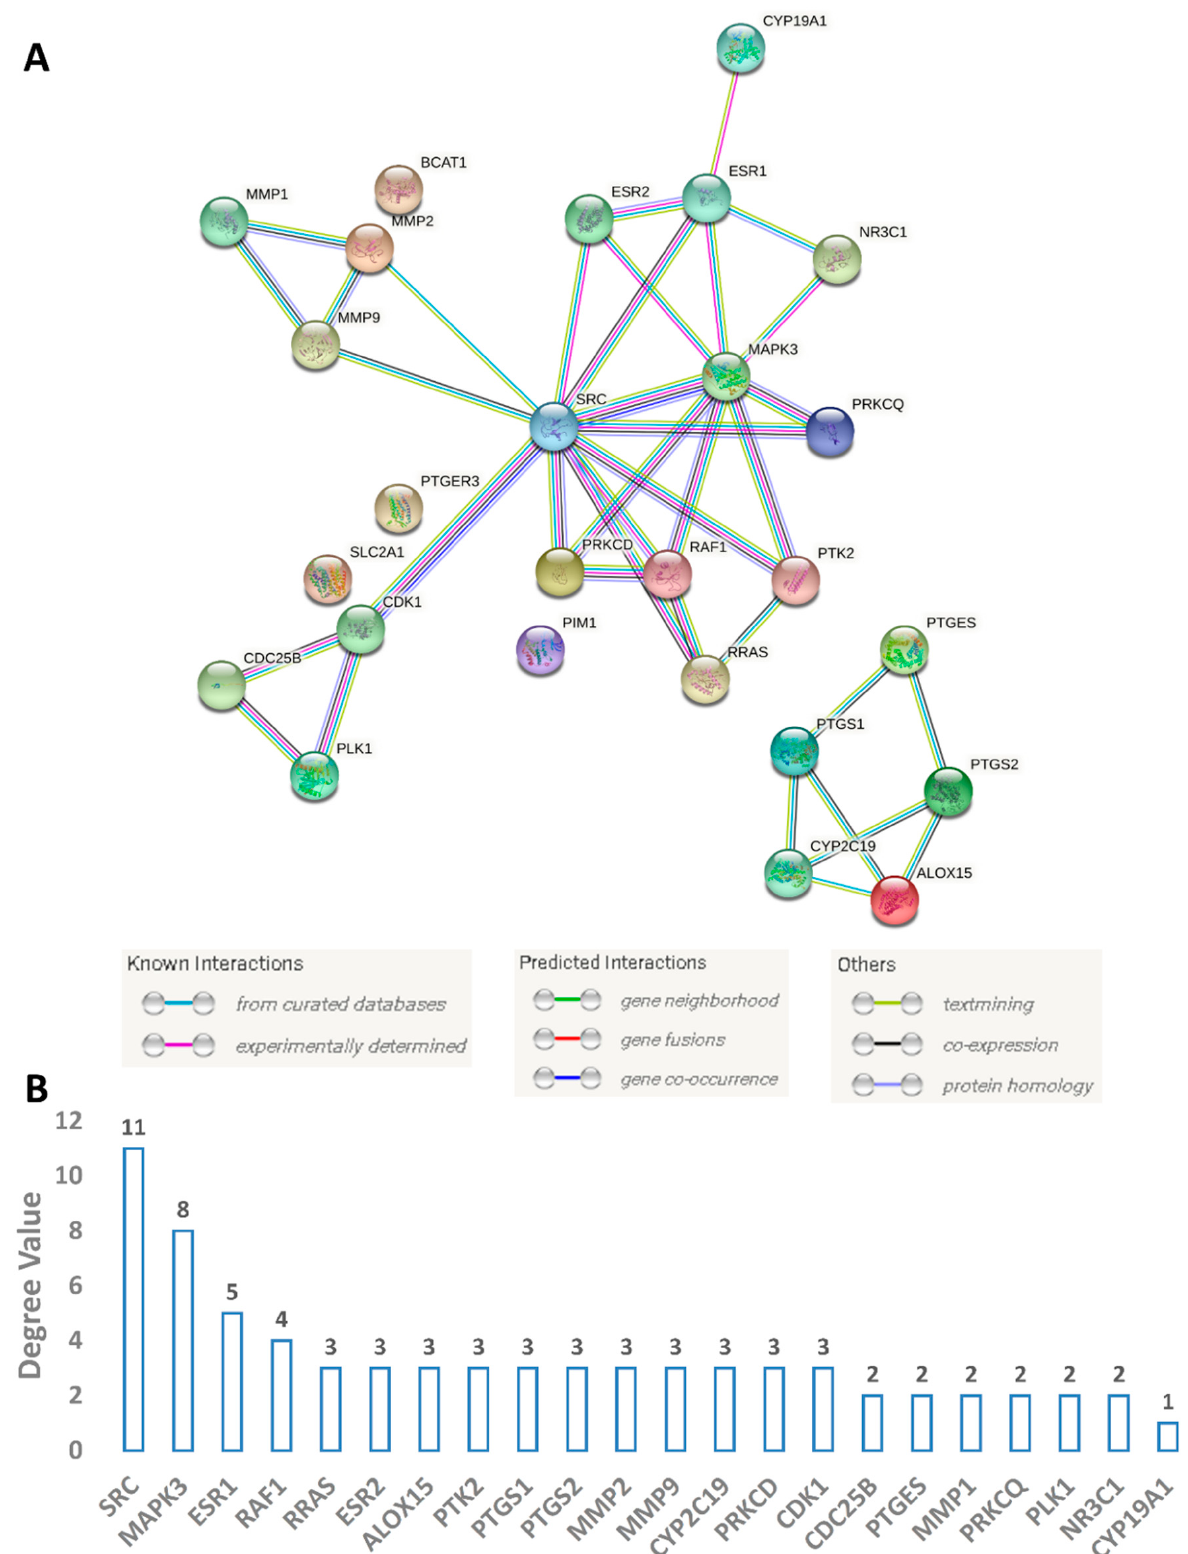
Figure 11. ( A ) BC sub-PPI network constructed from proteins predicted to be targeted by CE-derived compounds 1 – 20 . This network consists of 26 nodes and 37 edges with an average node degree of 2.85. ( B ) Degree values of the interacting nodes.